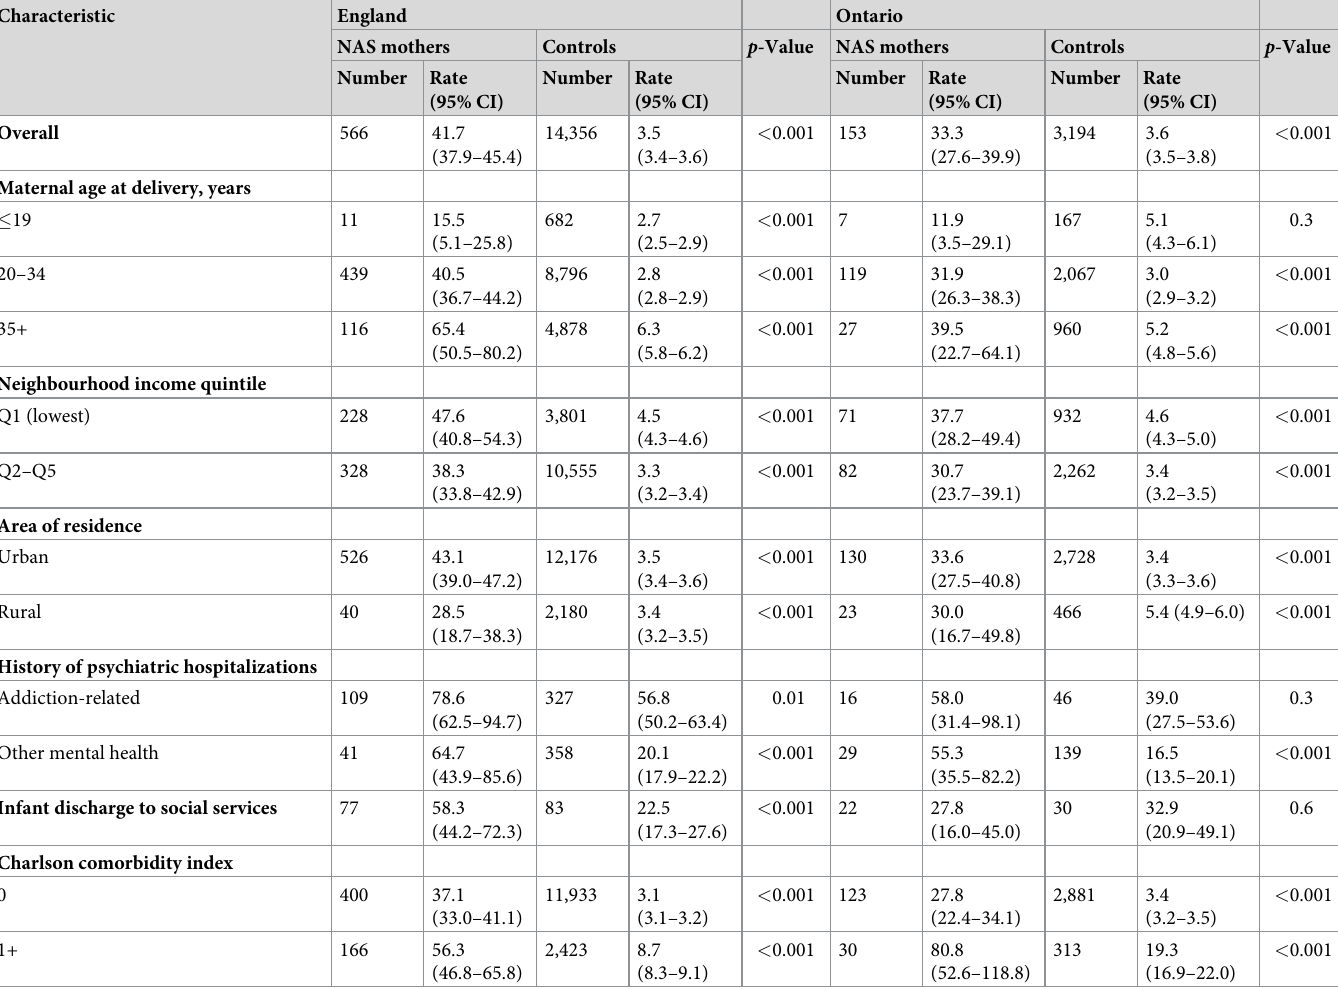
Table 3. Age-standardized all-cause mortality rates per 1,000 women, April 1, 2002, to March 31, 2016.